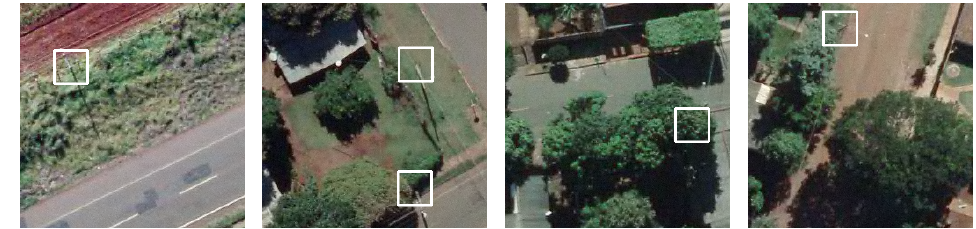
Figure 1. Examples of electric poles present in our